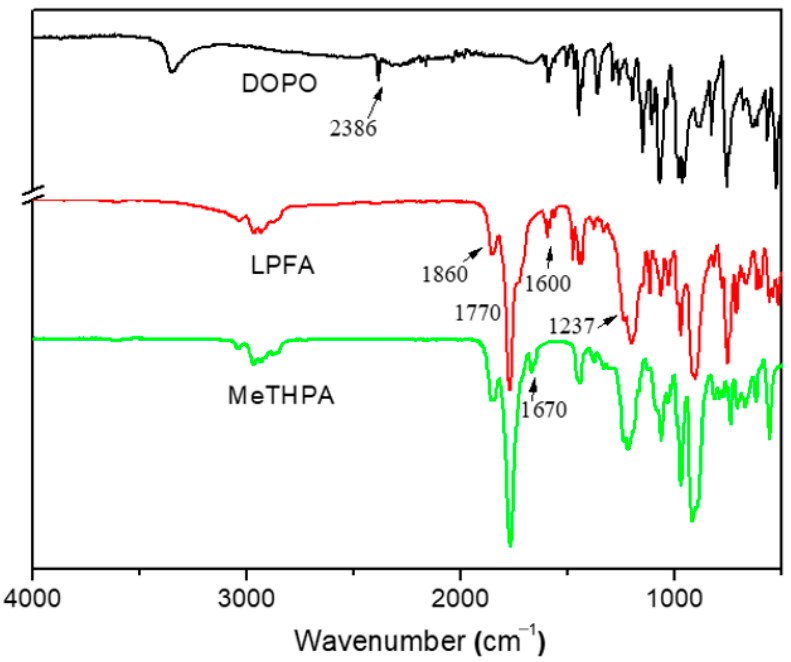
Figure 1. FT-IR of DOPO, MeTHPA and LPFA.